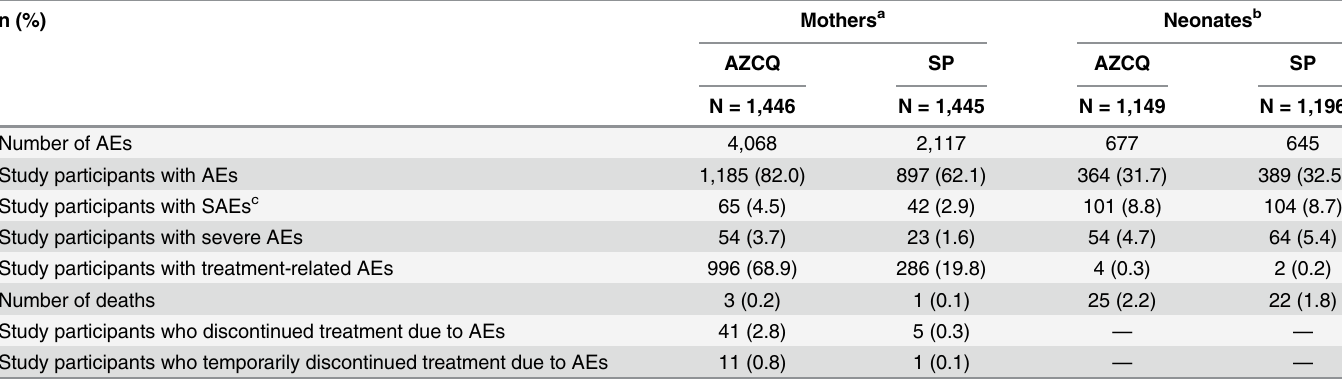
Table 4. Overview of adverse events in the safety